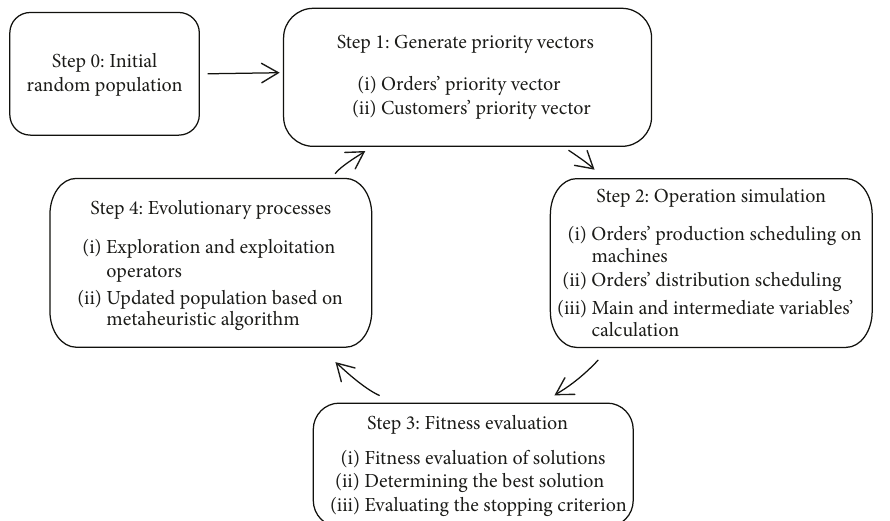
Figure 3: Intelligent procedure based on simulation and metaheuristic algorithms.